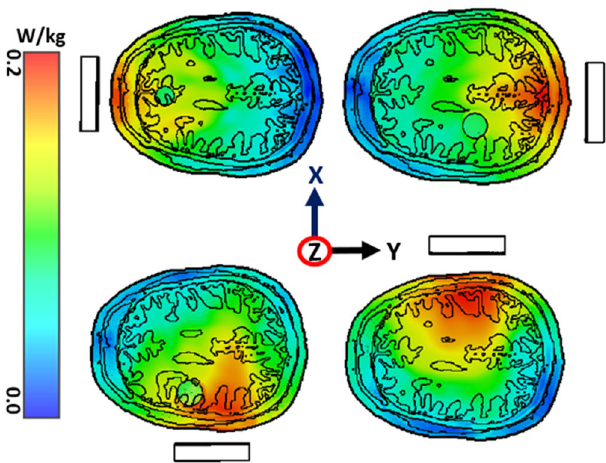
Figure 17. The specific absorption rate (SAR) inside the head phantom with antenna operation in different positions within XY-plane with 1mW input power at 2.20 GHz.